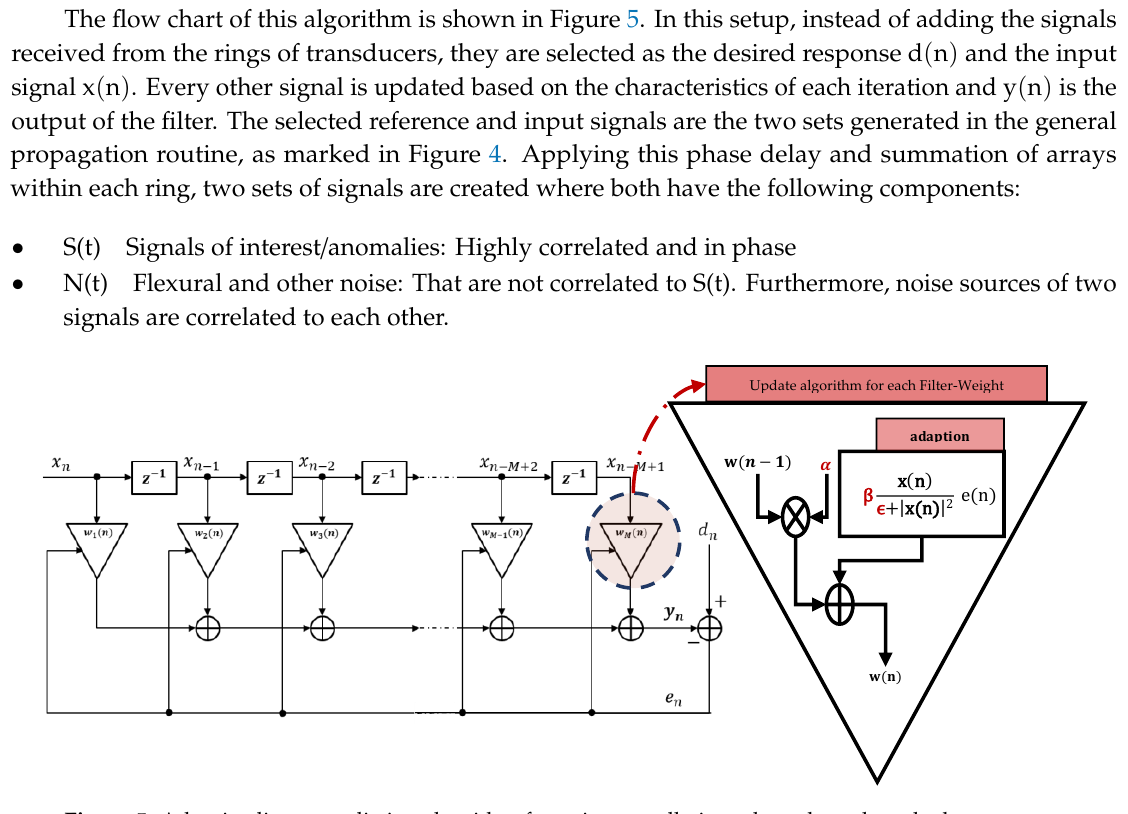
Figure 5. Adaptive linear prediction algorithm for noise cancellation where the red marked parameters are fixed by the user.